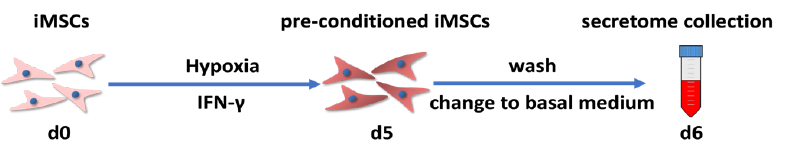
Figure 1. Timeline of IFN- γ stimulation and secretome collection: iMSCs were seeded into T-175 cell culture flasks (d0) and were stimulated with IFN- γ under hypoxic condition for 5 days (d5). Cells were washed and medium change to basal medium followed. After 24 h culture with basal medium, iMSCs secretomes were collected at day 6 (d6).